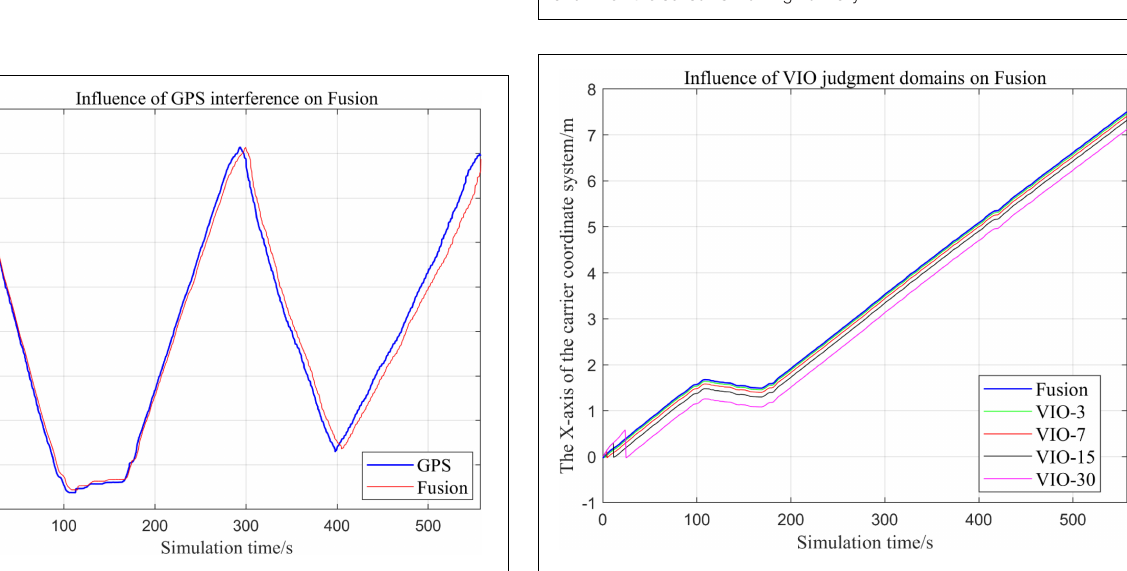
FIGURE 21 | Comparison of the overall trajectory in y -axis after GPS failure and when the sensor is working normally.